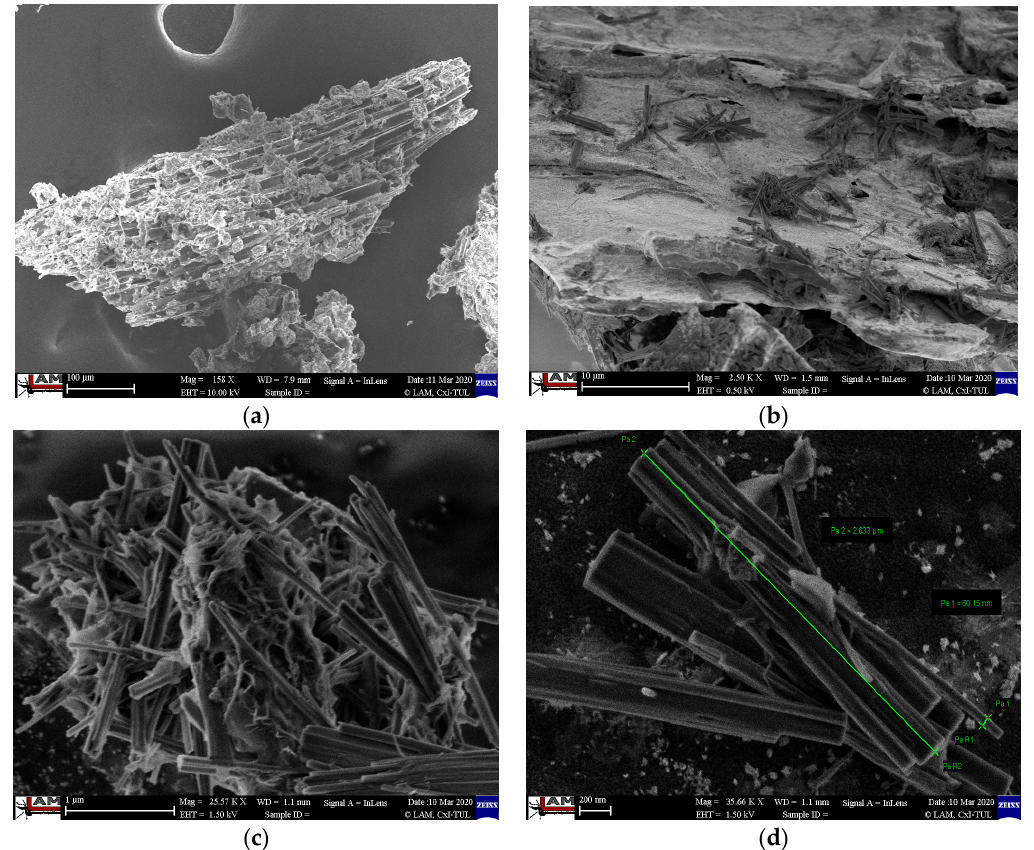
Figure 4. SEM images of the coke dust: ( a ) Particles’ shape; ( b , c ) Clusters of whiskers occurring on the surface of the coke dust particles; ( d ) Whiskers’ size.